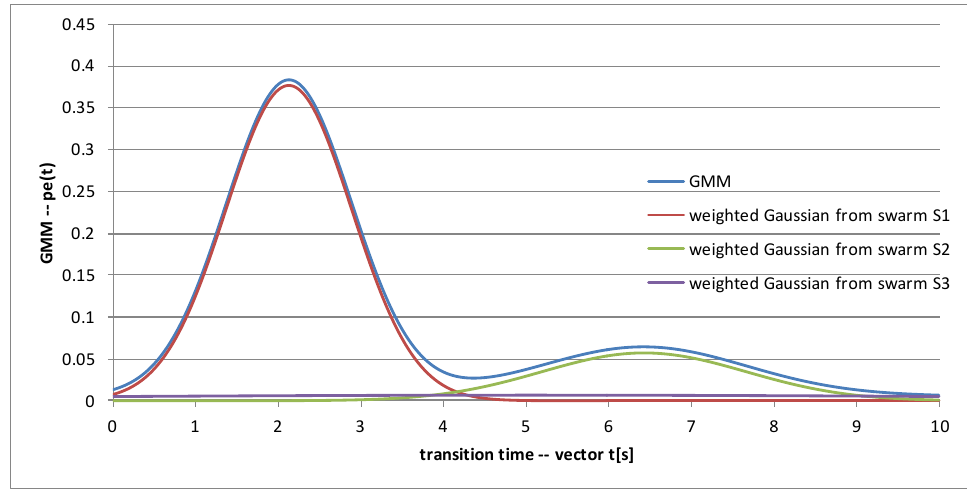
Figure 17. Normalized histogram and distribution of three different swarms when termination criterion for the last swarm S 3 is fulfilled.